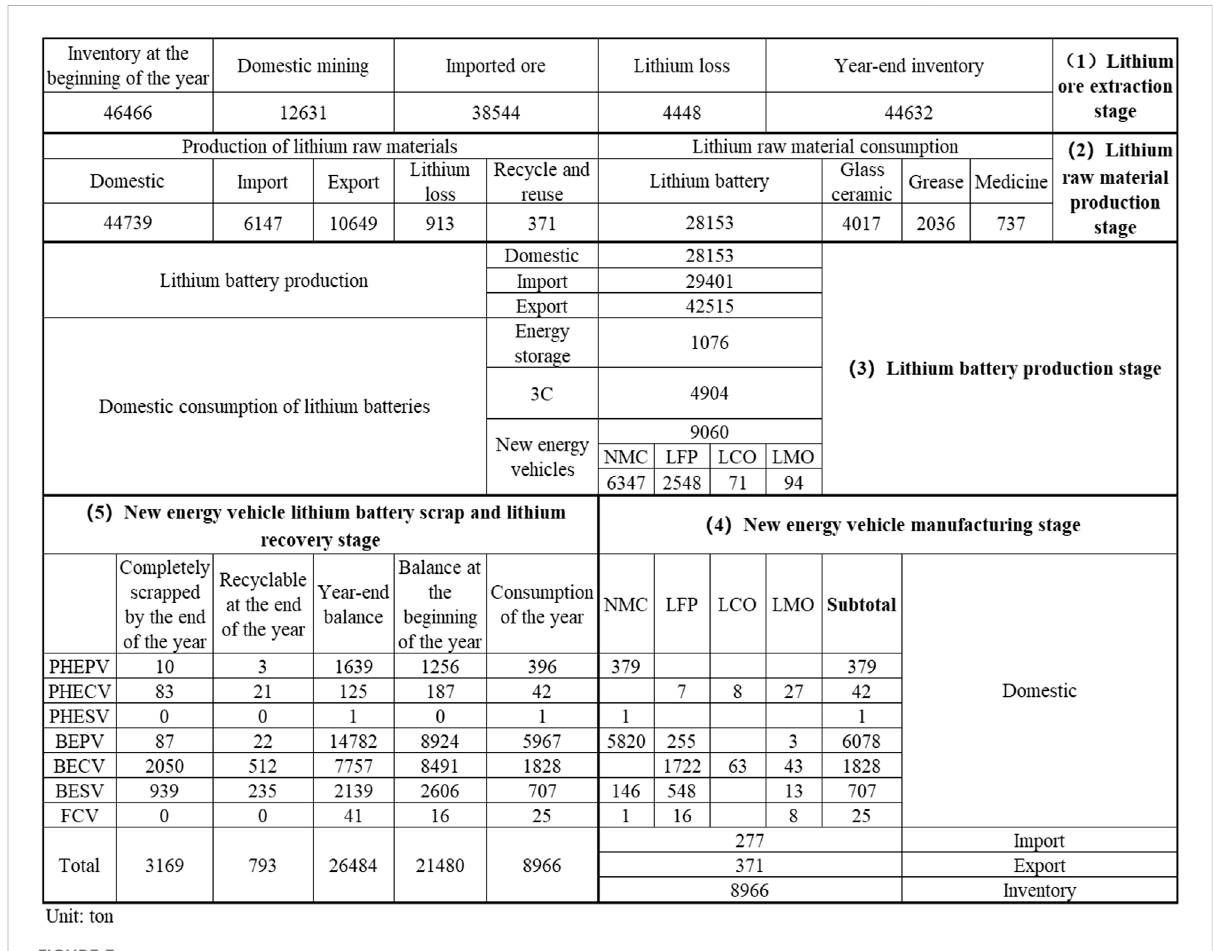
FIGURE 3 New energy vehicle industry lithium material fl ow meter in